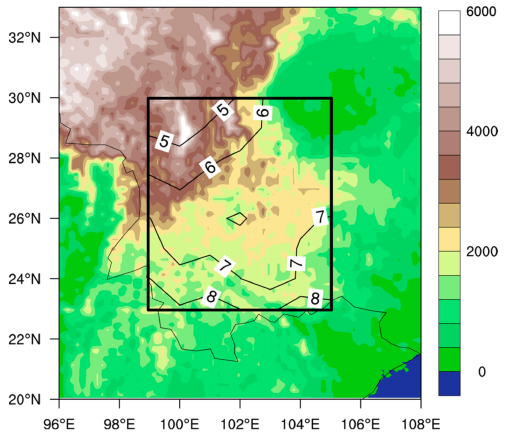
Figure 1. Climatological mean of summer precipitation (contour; mm day − 1 ) for the period of 1921–2016 and the terrain (shading; m) of Southwestern China. The rectangle denotes the studied region for Southwestern